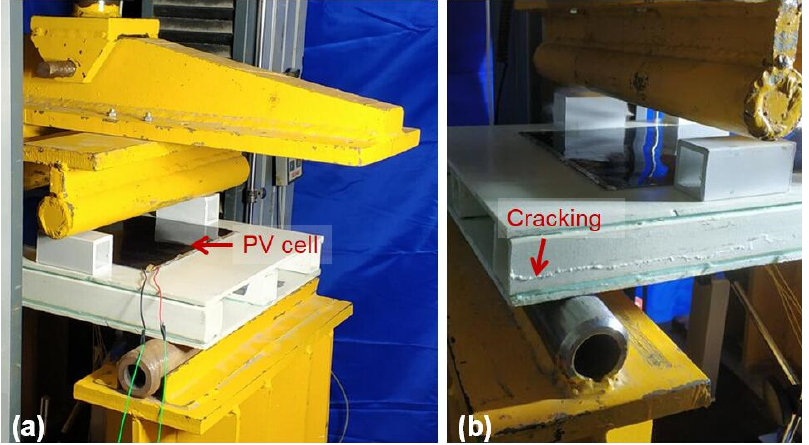
Figure 5. Four-point bending experiment on integration: ( a ) test setup and ( b ) specimen cracking after loading.